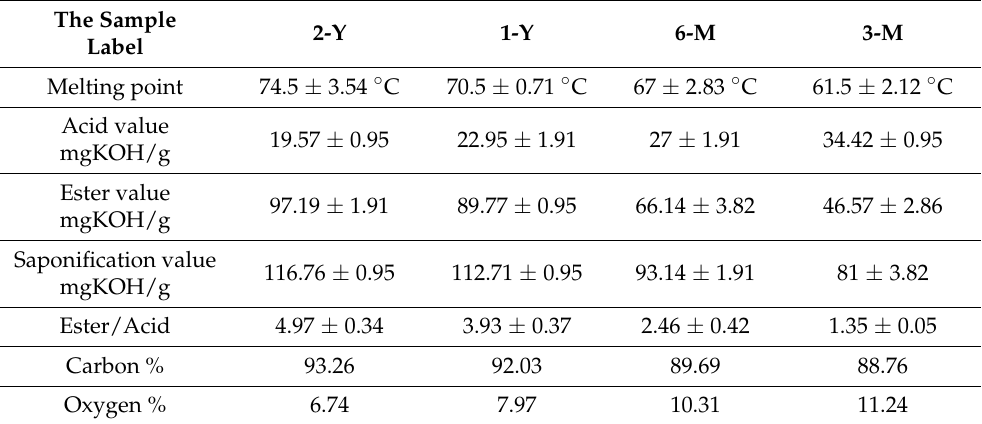
Table 2. Chemical constituents of the different beeswax samples.